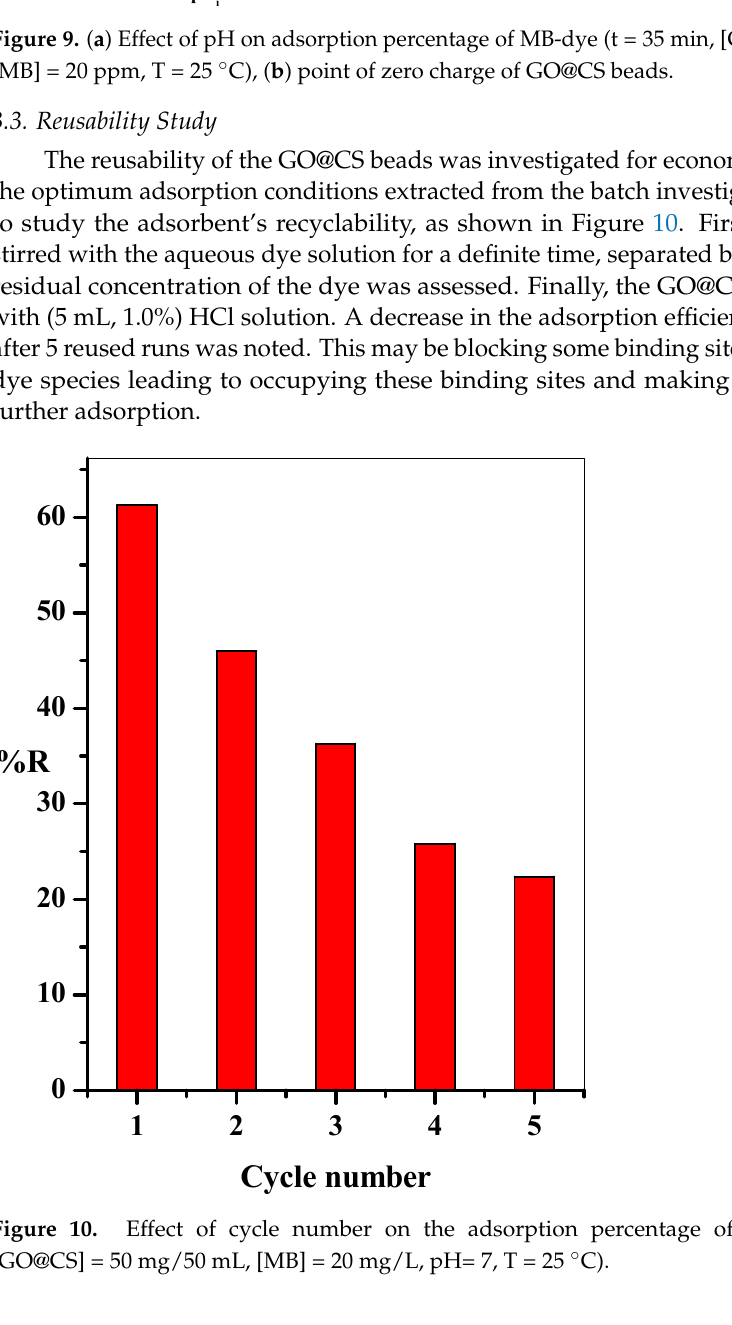
Figure 9. ( a ) Effect of pH on adsorption percentage of MB-dye (t = 35 min, [GO@CS] = 50 mg/50 mL, [MB] = 20 ppm, T = 25 ◦ C), ( b ) point of zero charge of GO@CS beads.